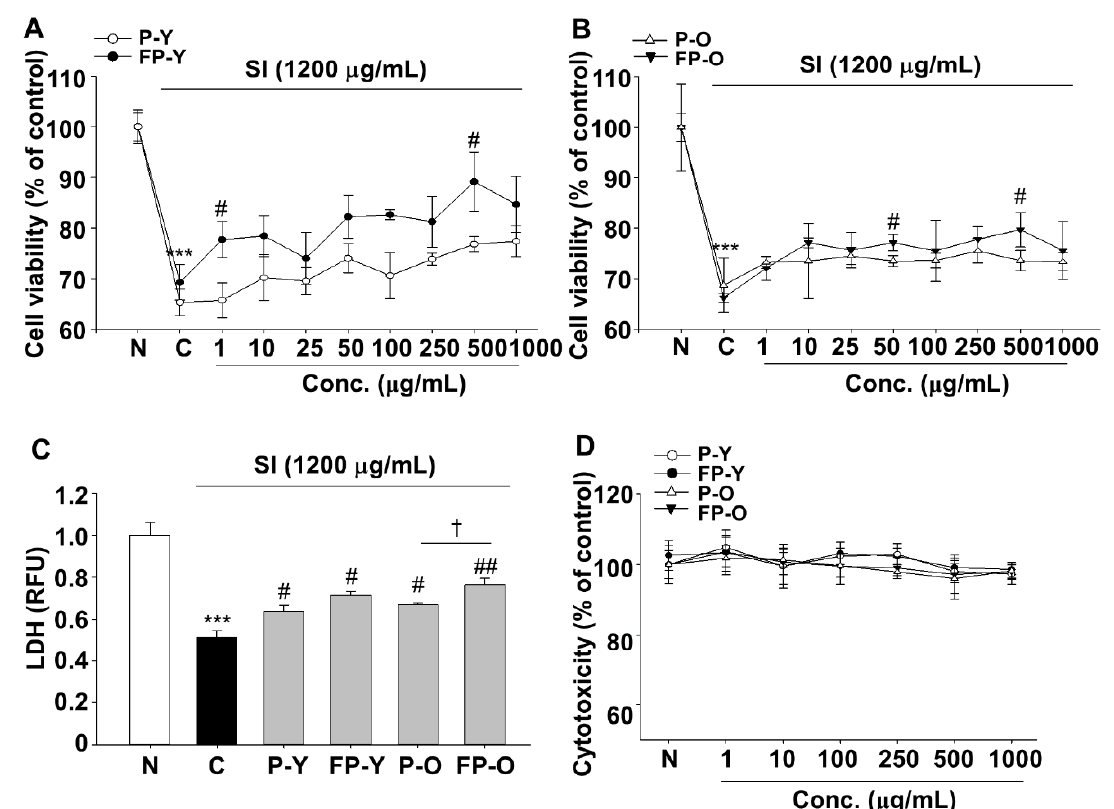
Figure 1. Sodium iodate (SI)-induced damage of human RPE cells (ARPE-19) was decreased by fermented yellow or or- ange paprika (P-Y or -O) extracts. Cells were exposed to SI (1200 μg/mL) in presence or absence of various doses of P (-Y or -O) and FP (-Y or -O) extracts for 24 h. Protective effects of ( A ) P-Y, FP-Y, ( B ) P-O, and FP-O extracts on SI-induced damage in ARPE-19 cells. ( C ) Cell viability was determined using LDH leakage assay. The SI-induced cell damage was reduced at 500 μg/mL of P (-Y or -O) and FP (-Y or -O) extracts. ( D ) Cell cytotoxicity was analyzed using the MTT assay. *** p < 0.001 vs. N, # p < 0.05, ## p < 0.01 vs. C) † p < 0.05 vs. P-O. Values are means ± SEM. Significant differences between the groups were determined by analysis of variance (ANOVA) followed by Duncan’s multiple range test. Conc., Concentration; N, Normal; C, Control; P-Y, Yellow Paprika; P-O, Orange Paprika; FP-Y, Fermented P-Y; FP-O, Fermented P-O.